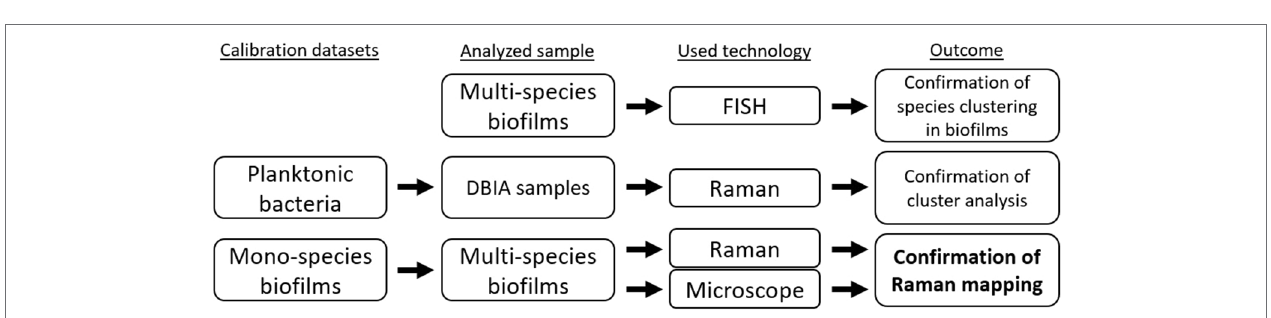
FIGURE 1 | Averaged processed Raman signals (300 spectra for each dataset) before Savitzky–Golay differentiation for Streptococcus oralis and Actinomyces denticolens and their SDs. (A) shows the spectra for A. denticolens for planktonic bacteria and (B) for mono-species biofilms. (C) shows the absolute % difference between planktonic bacteria and mono-species biofilm spectra. (D) shows the S. oralis spectra for planktonic bacteria and (E) for mono-species biofilms. (F) shows the absolute % difference between planktonic bacteria and mono-species biofilm spectra. (G) shows the absolute % difference between A. denticolens and S. oralis for planktonic bacteria and (H) for mono-species biofilms.